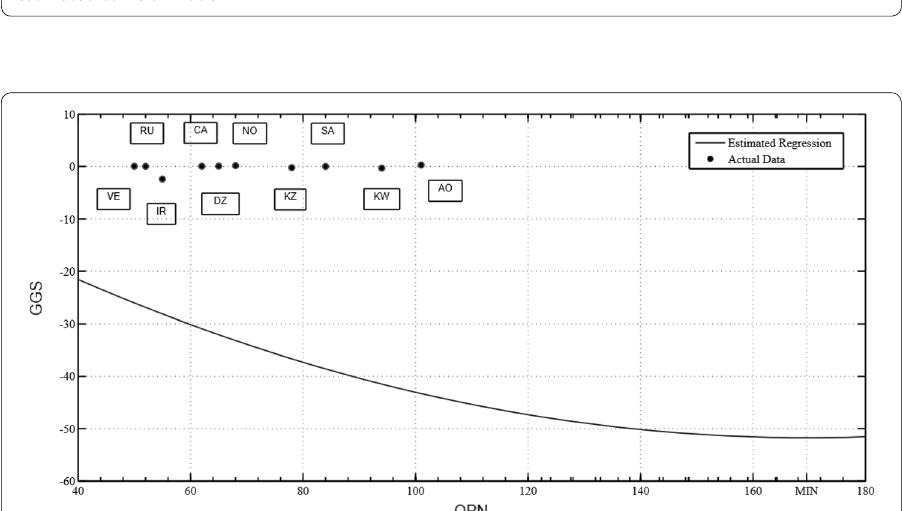
Fig. 3 GDP growth versus openness in the ten oil-exporting countries: the actual data in 2012 and the estimated curve of model 1-N